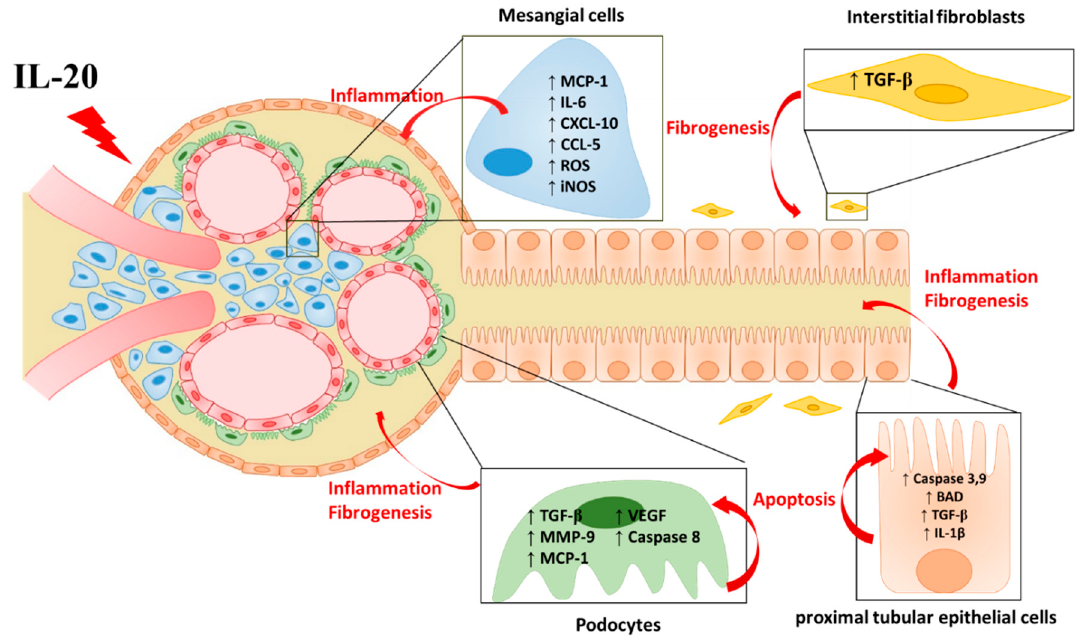
Figure 1. The effect of IL-20 in renal cells. IL-20 acts on interstitial fibroblasts, renal epithelial cells, mesangial cells, and podocytes and contributes to the progression of kidney disease, including inflammatory response, renal fibrosis, and cell apoptosis. ↑ = increased; ↓ = decrease.